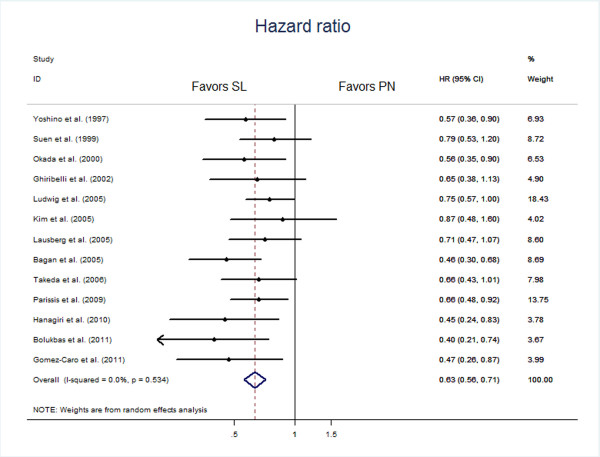
Meta-analysis of overall survival hazard ratios in individual studies and across all studies.